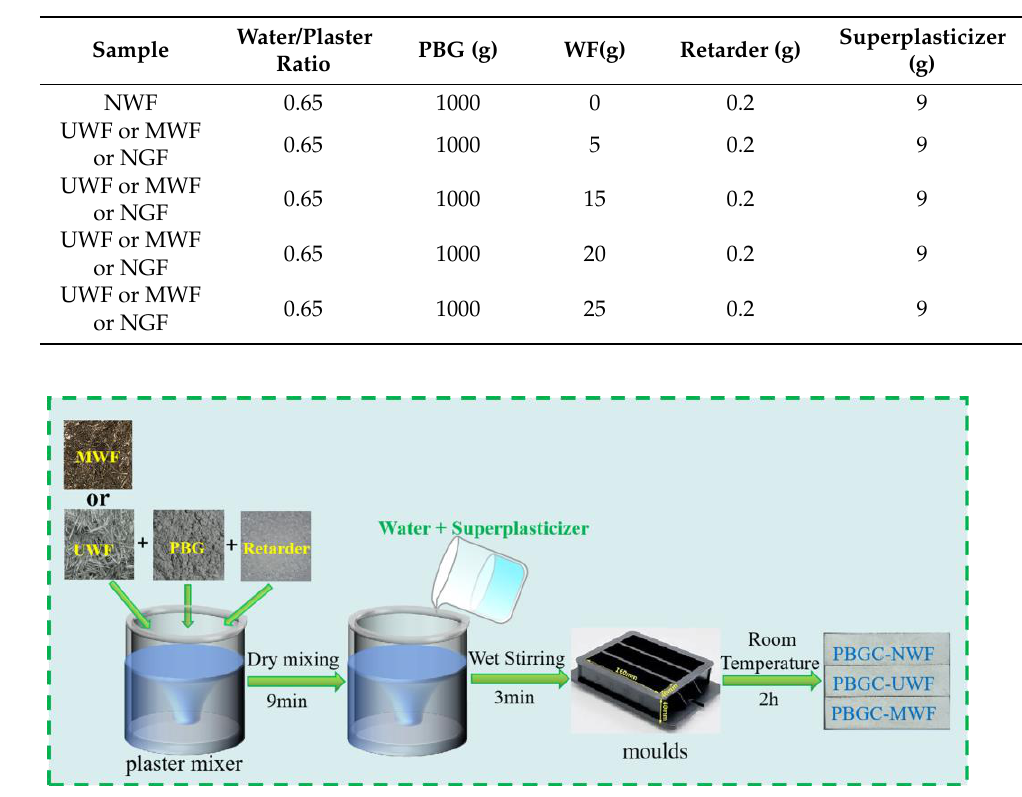
Table 2. Mix proportions of PBGC samples.